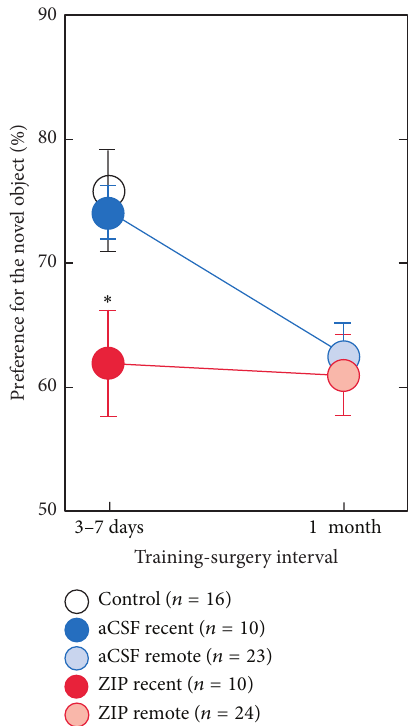
Figure 2: Preference for the novel object after infusion for recent and remote memory conditions. In the recent memory condition, all groups performed above chance, but rats with ZIP infusions (red) performed worse than rats with aCSF infusions (blue) and control (white) rats. In the remote memory condition, both ZIP (light red) and aCSF (light blue) groups performed similarly and above chance. Error bars indicate SEM. Asterisk indicates difference from aCSF and control groups ( 𝑃 < 0.05 ). All groups performed above chance ( 𝑃 < 0.05 , chance =